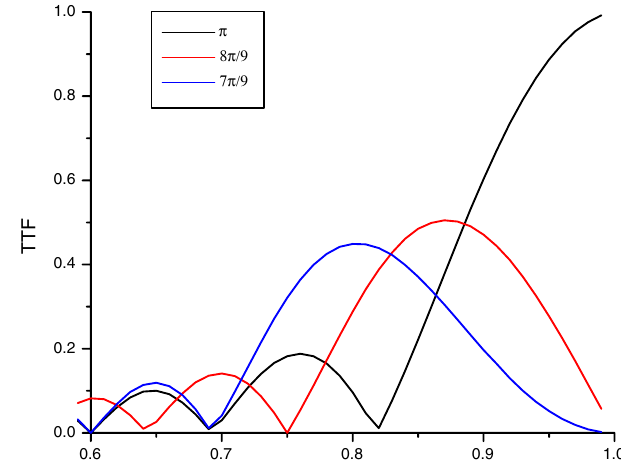
FIG. 2. (Color) Transit time factor of 3 adjacent modes as a function of the particle relative velocity.